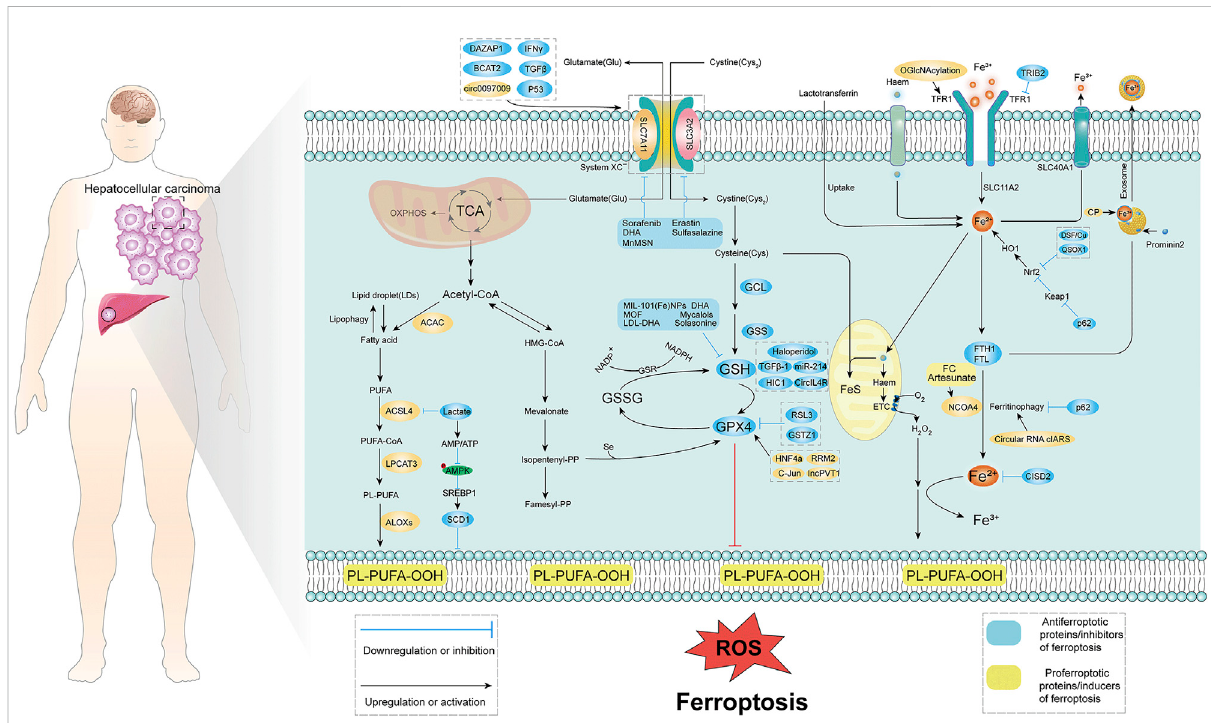
FIGURE 1 Molecular mechanism of ferroptosis in HCC. Ferroptosis is mainly caused by lipid peroxidation, and proper induction of ferroptosis may be an effective treatment for related cancers. The occurrence of ferroptosis mainly involves three aspects: System xc − , iron metabolism, p53, and lipid peroxidation. System xc − introduces cystine into cells primarily at a 1:1 reverse amino acid transport ratio, ultimately in glutamate-cysteine ligase (GCL), glutathione synthase (GSS), glutathione Induced intracellular lipid peroxidation under the action of peptide peroxidase. Iron metabolism ismainly caused by lipidperoxidation caused by excessive release of ironions with theparticipation ofironions. Lipid peroxidation ismainly through fatty acid-induced lipid peroxidation. TCA, tricarboxylic acid cycle; ROS, reactive oxygen species; GSH, glutathione; GPX4, glutathione